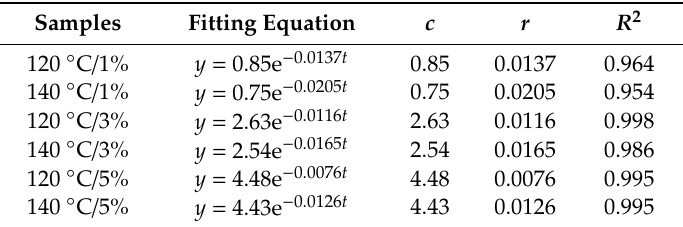
Figure 3. Stabilizing time of foamed asphalt under different conditions.